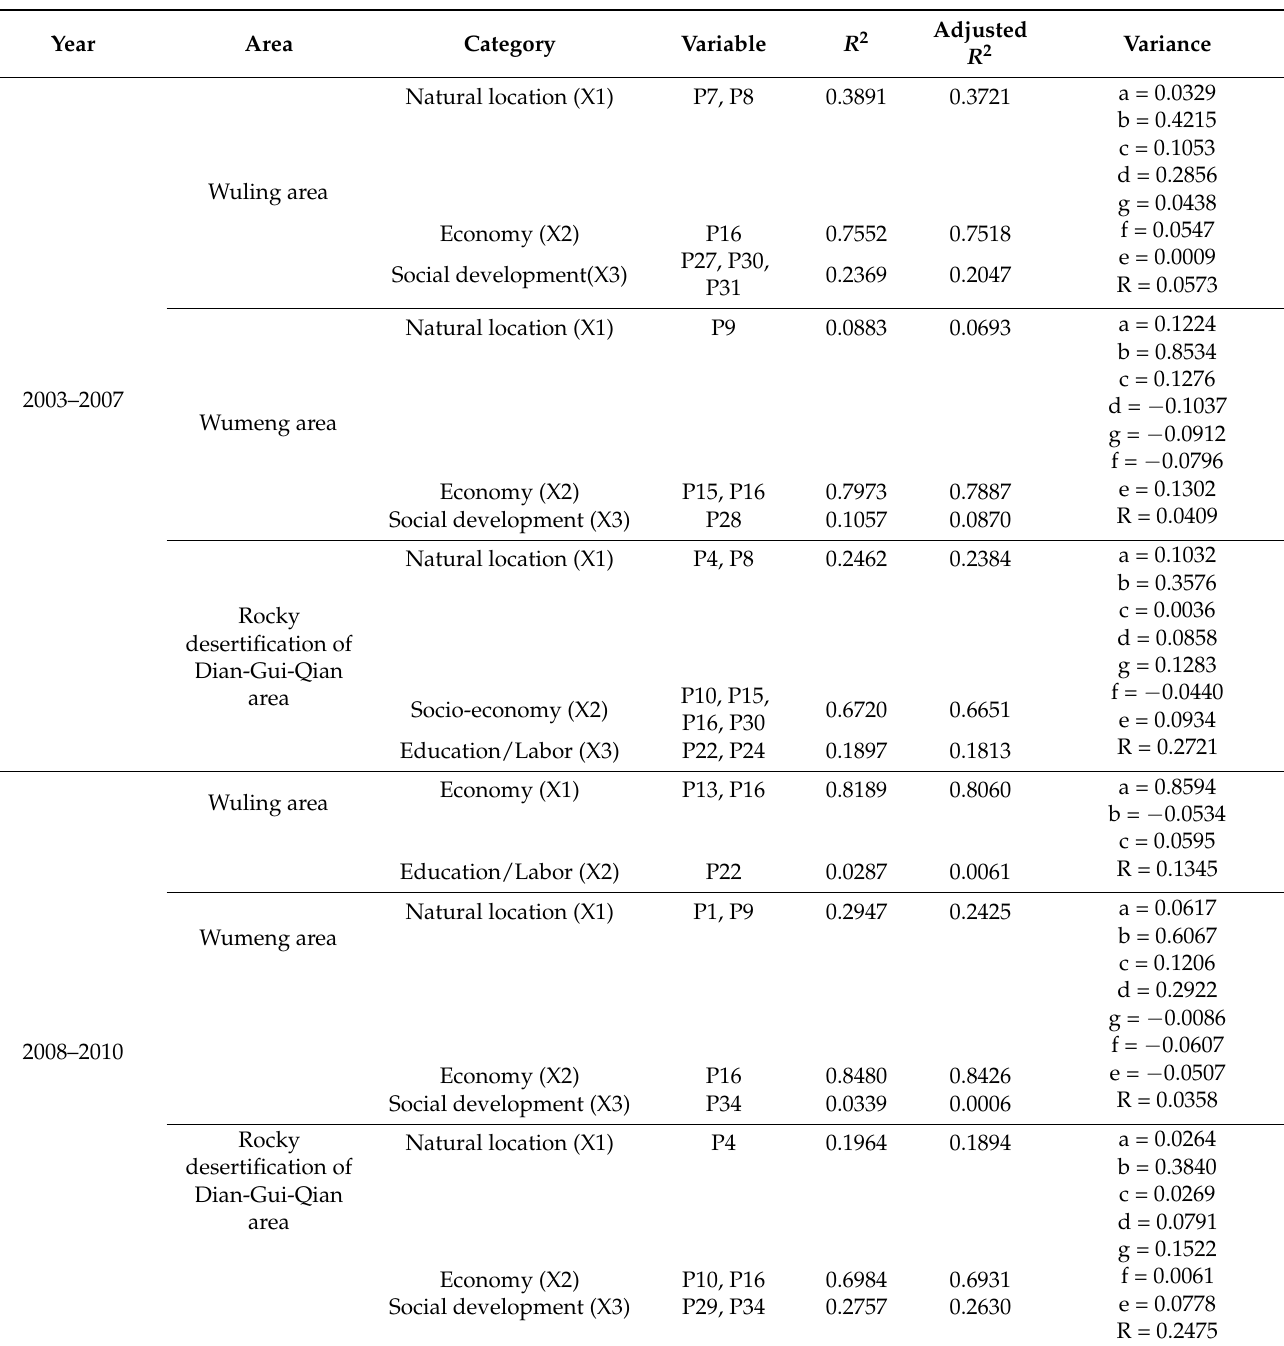
Table 3. Statistics of the variance decomposition in the three continuously poverty-stricken